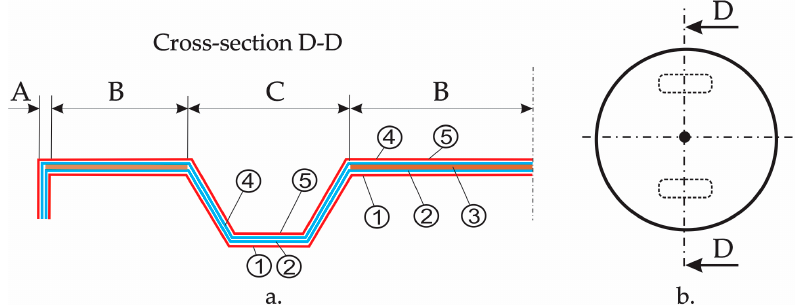
Figure 3. Schematic layout of the layers for the manhole cover (one to five are layers whose materials are shown in Table 1): ( a ) Layout of the layers corresponding to half of cross-section D-D of the manhole cover; ( b ) Top view of the manhole cover (handling areas are shown with dashed